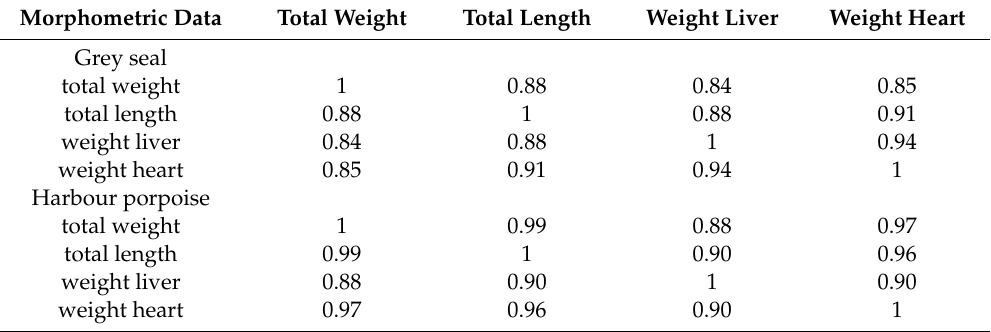
Table 2. Pearson correlation coe ffi cient between total weight, total length, and weight of the liver as well as the heart in grey seals (n = 17) and harbour porpoise (n = 8).